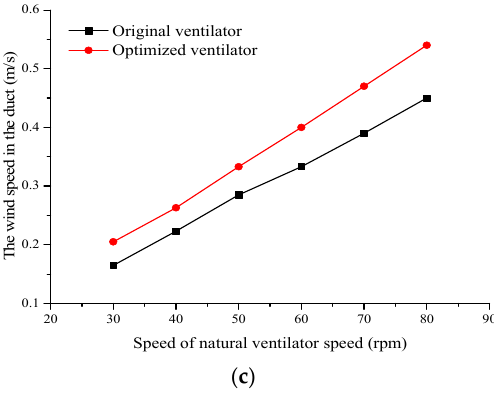
Figure 20. Relationships between wind speed in the air duct and natural ventilator speed before and after optimization at different testing points. ( a ) Testing point 3; ( b ) Testing point 4; ( c ) Testing point 5.